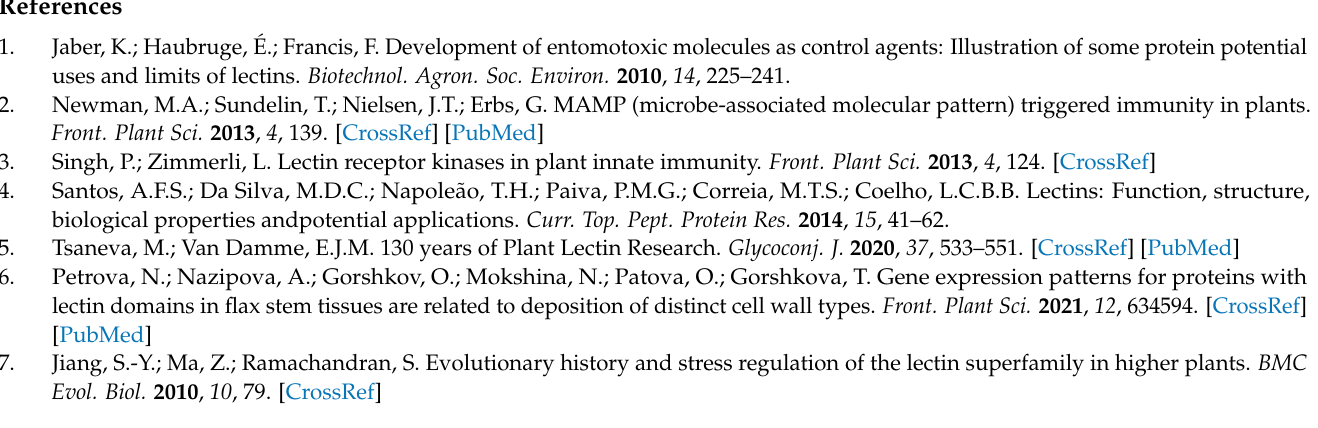
Table S1. Cluster 1: Lectin genes down-regulated in flax root tips in response to Fusarium oxysporum . Table S2. List of genes coexpressed with Lus10041798 ( BGAL3 ). Table S3. List of genes coexpressed with Lus10035954 (Malectin family). Table S4. Cluster 2: lectin genes upregulated in flax root tips in response to Fusarium oxysporum . Table S5. List of genes coexpressed with Lus10028377